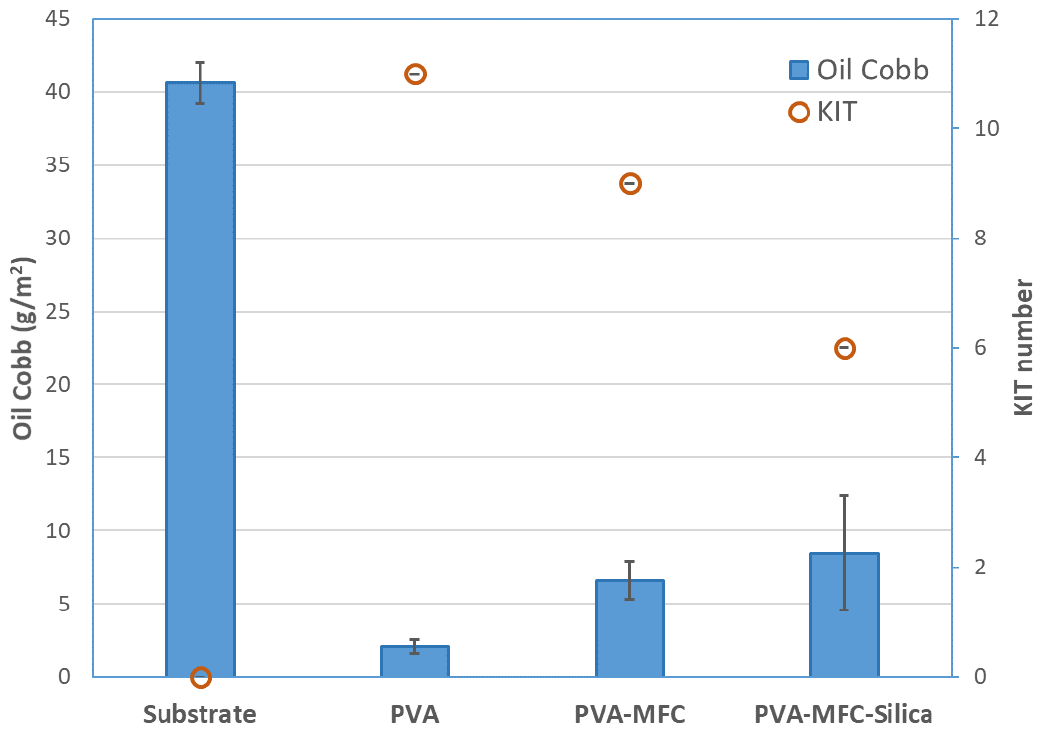
Figure 4. Oil Cobb and KIT test results for the substrate and coatings.